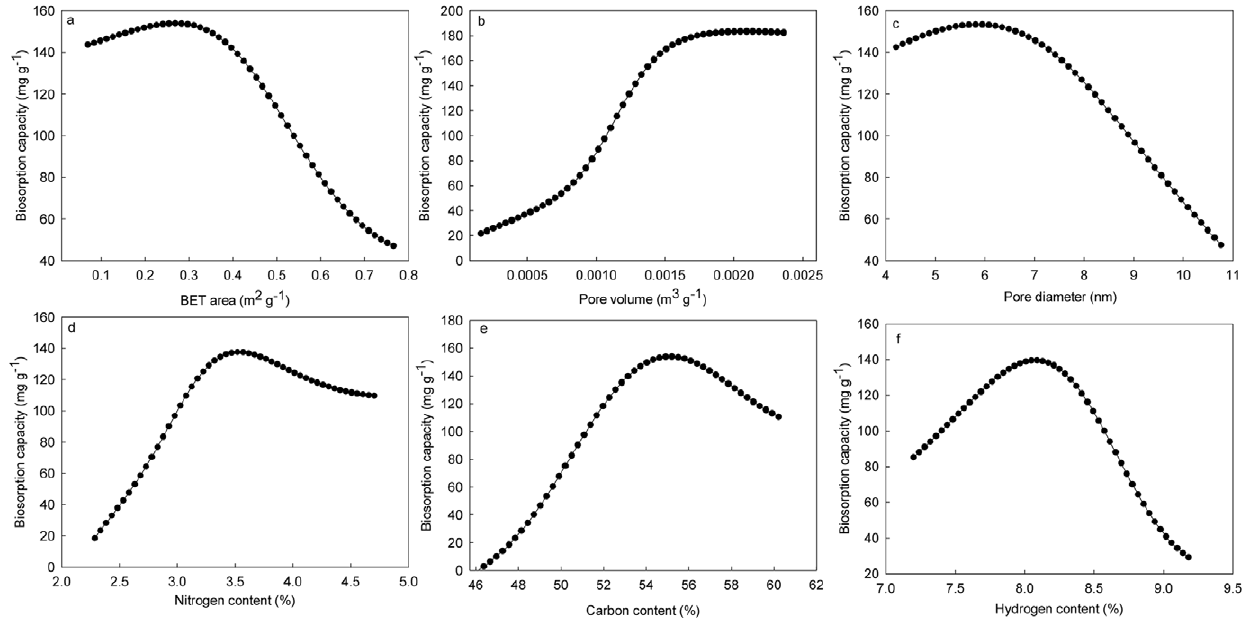
Figure 1. The effects of textural characteristics and chemical element compositions on biosorption as predicted using an artificial neural network model by changing the values for the variable of interest while holding the other variables constant.